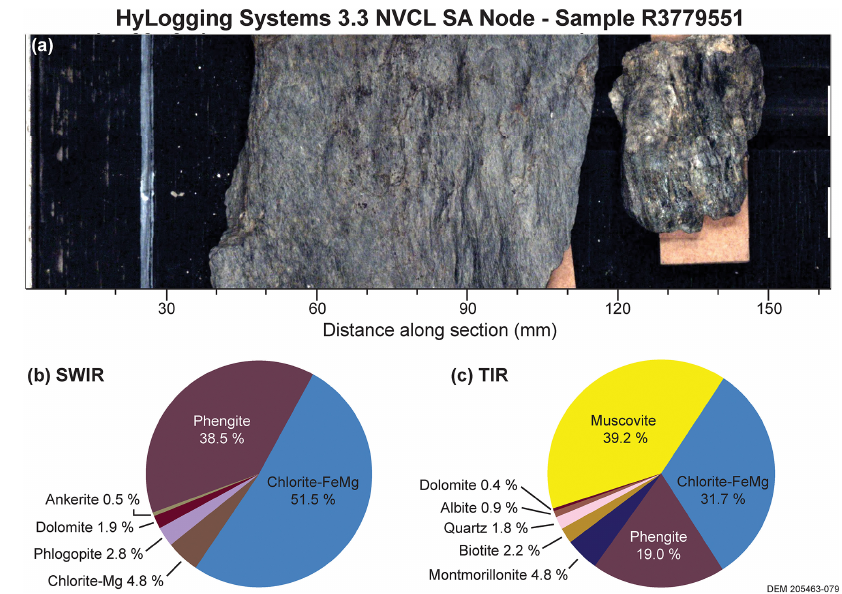
Figure A4. Hyperspectral mineralogy results for sample 3779551.